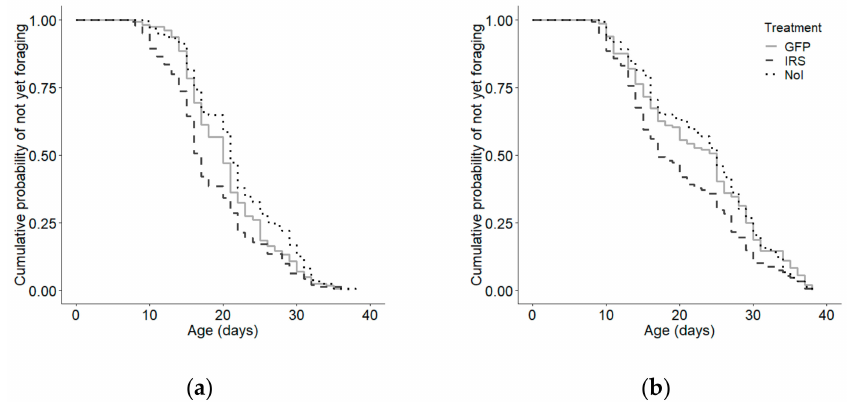
Figure 2. E ff ect of irs knockdown on age of foraging onset for all bees in ( a ) colony 1 and ( b ) colony 2. There was a significant overall e ff ect of treatment on age of foraging onset in both colony 1 (Kaplan–Meier: χ 2 = 15.3, p < 0.0001; n = 456) and (b) colony 2 (Kaplan–Meier: χ 2 = 9.9, p = 0.007, n = 438). irs knockdown (IRS) induced an early onset of foraging behavior relative to injected GFP controls in both colonies (Cox–Mantel: Colony 1: p = 0.039, Colony 2: p = 0.011). There was no e ff ect of handling or injection stress on age of first foraging (Cox–Mantel: Colony 1: p = 0.23, Colony 2: p =